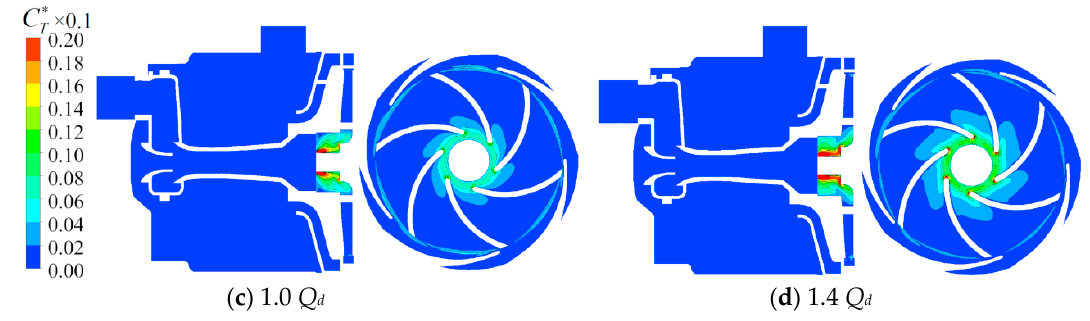
Figure 10. Fluctuation intensity distribution contours of velocity on two planes under four conditions.